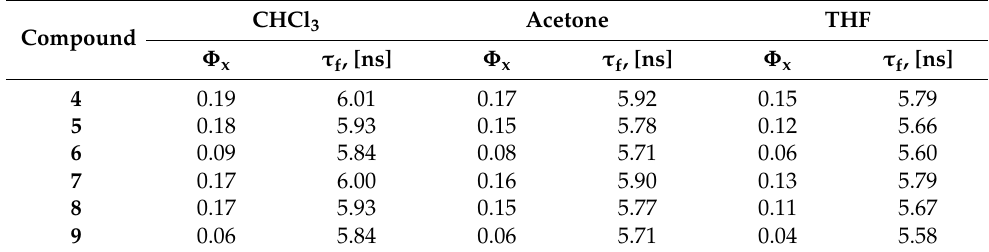
Table 2. Photophysical characteristics of compounds 4 – 9 in organic media.